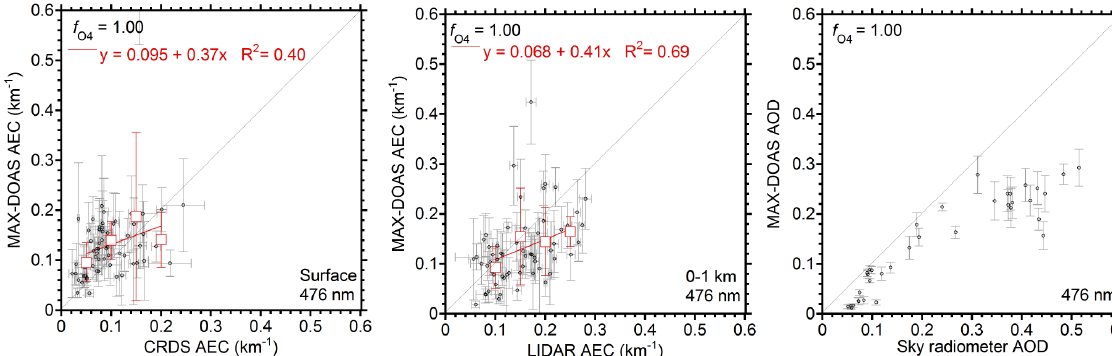
Figure 7. Same as Fig. 5, but a f O